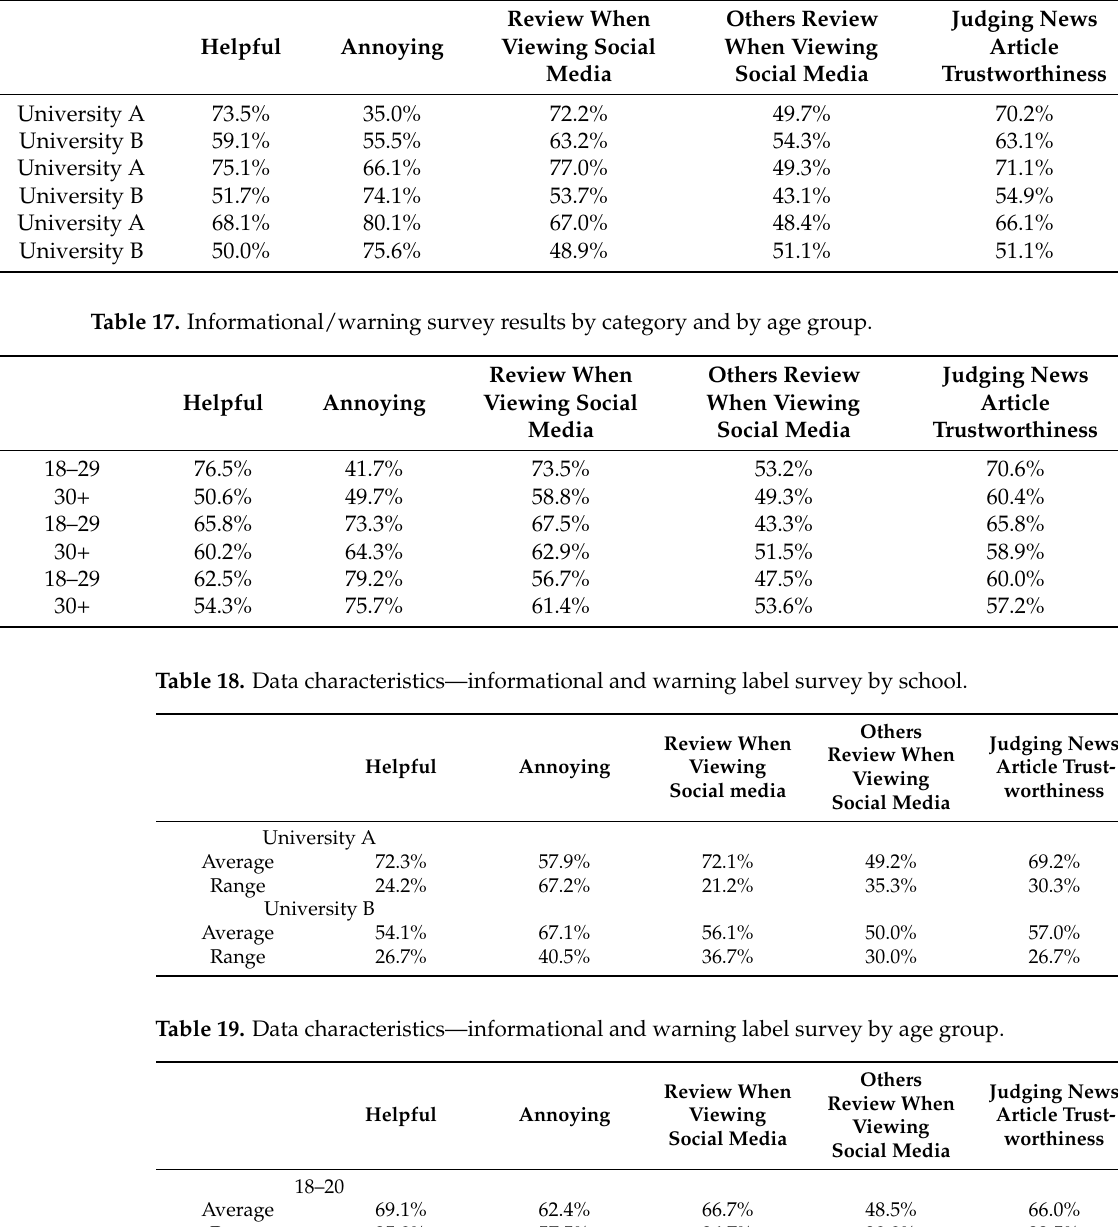
Table 16. Informational/warning survey results by category and by school.